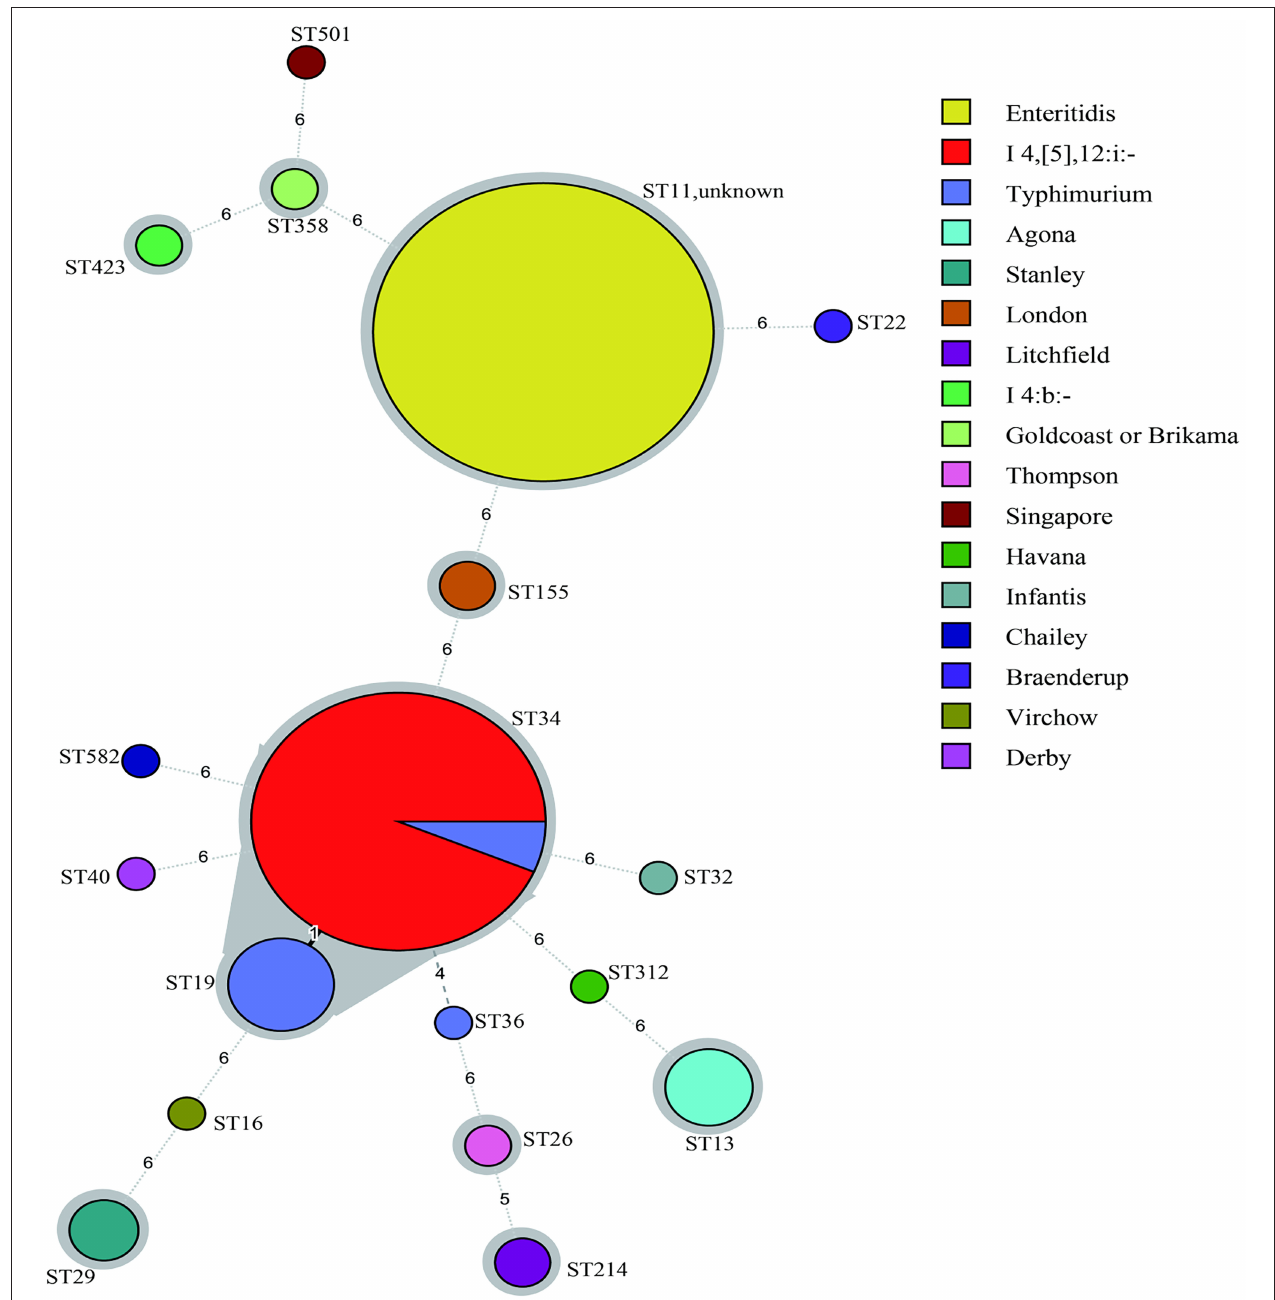
FIGURE 1 | Minimum spanning tree (MST) of multilocus sequence typing (MLST) for 260 Salmonella strains. Allele distances among strains were labeled and STs were coded. The circle size represented the number of strains. The circle’s color was filled according to serotypes and shades of gray indicated a close tie with